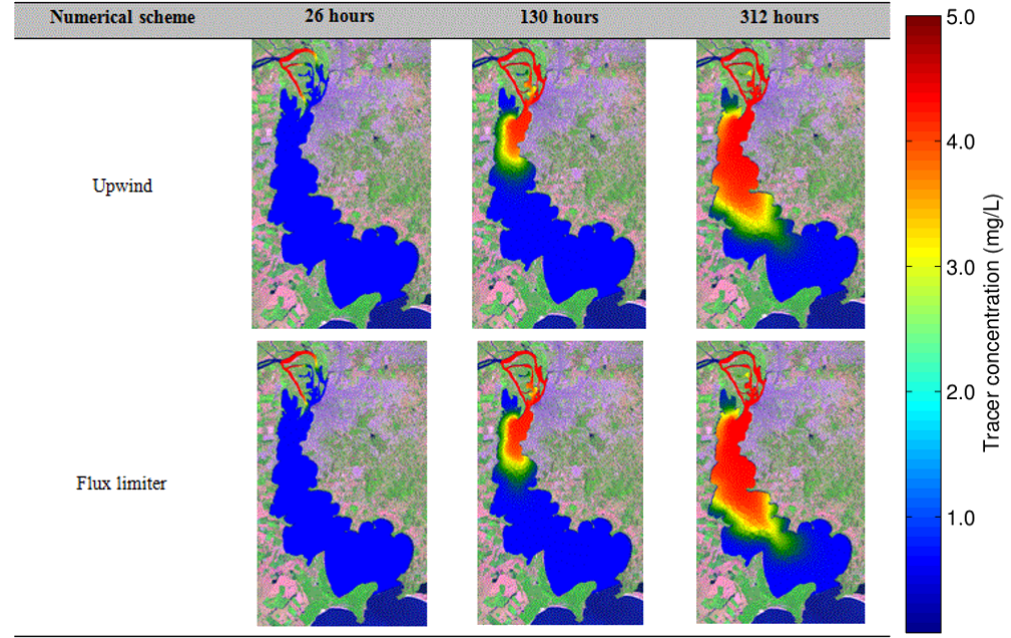
Fig. 7. Concentration field of a tracer plume calculated using the flux-limiter and upwind schemes for 26, 130 and 312h in the Guaíba River, Fig. 7: Concentration field of a tracer plume calculated using the flux limiter and upwind schemes for 26, 130 and 312 hours in the River Gua´ıba where where red computational cells denote values of concentration higher than 4.5mgL − 1 , while blue cells mean values of concentration lower red computational cells denote values of concentration higher than 4.5 mgL − 1 while blue cells mean values of concentration lower than 2.0 mgL − 1 . than 2.0mgL − 1 .